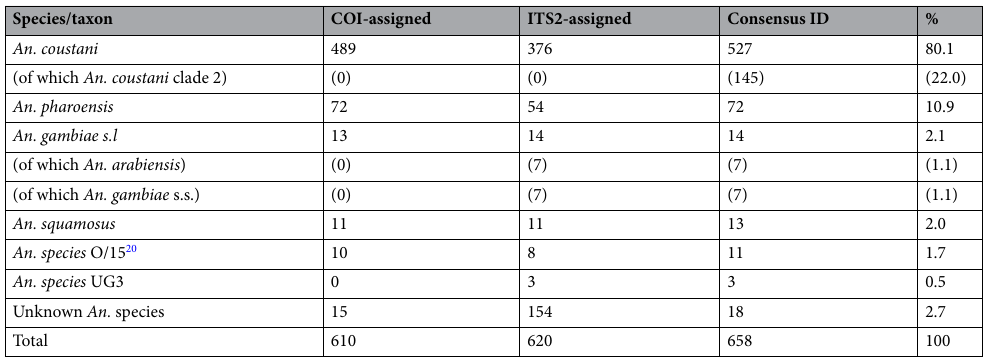
Table 1. Species identities assigned to Anopheles larvae based on mitochondrial and nuclear DNA sequences. Identities inferred from above-threshold matches to cytochrome c oxidase I (COI) and/or internal transcribed spacer region 2 (ITS2) sequences on GenBank (National Center for Biotechnology Information nucleotide database). Larval sampling undertaken May–June 2019 in Limulunga and Mongu districts, Zambia.